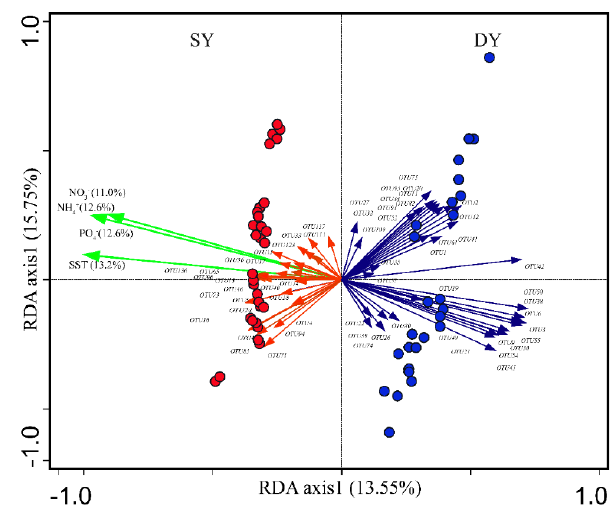
Figure 3. RDA (Redundancy analysis) depicting the relationships of coral microbiomes (top 60 OTUs) with hosts and environmental parameters. The arrows represent coral microbiome enriched in the tropical SY (red) and the subtropical DY (blue) reefs, respectively. The green arrows represent environmental factors. The solid cycles represent coral samples from the tropical SY (red) and the subtropical DY (blue) reefs, respectively.